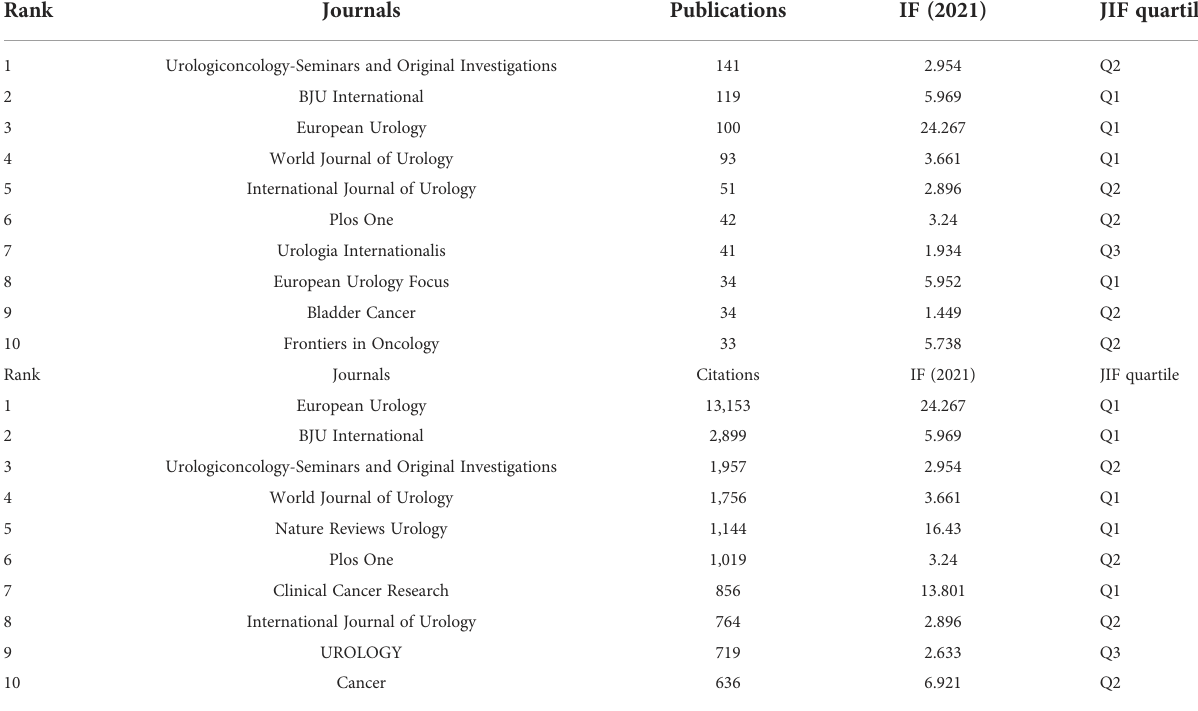
TABLE 4 Top 10 Journals by publications and citations.